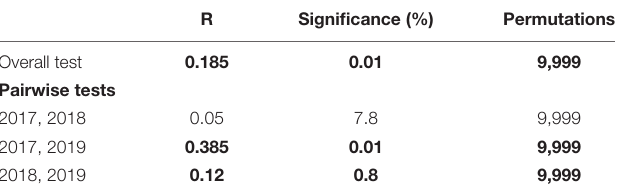
TABLE 1 | One-way ANOSIM of year as a significant factor in the ordination of Bray-Curtis similarities between benthic transect samples ( n = 68) with pairwise tests (significant differences in